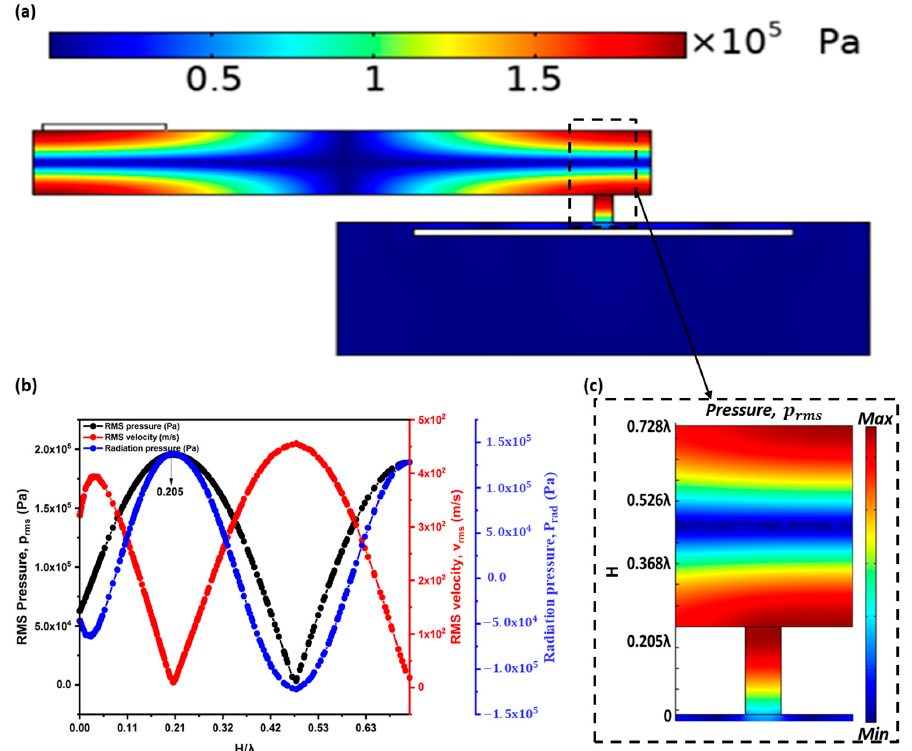
Figure 4. Numerical simulation results at acoustic cavity of height, H of ( a ) RMS pressure, velocity, and radiation-pressure responses, ( b ) RMS pressure distribution, ( c ) RMS pressure at acoustic cavity of height, H where the nozzle outlet has to be placed at H = 0.205 λ within the Fabry–Pérot resonator.